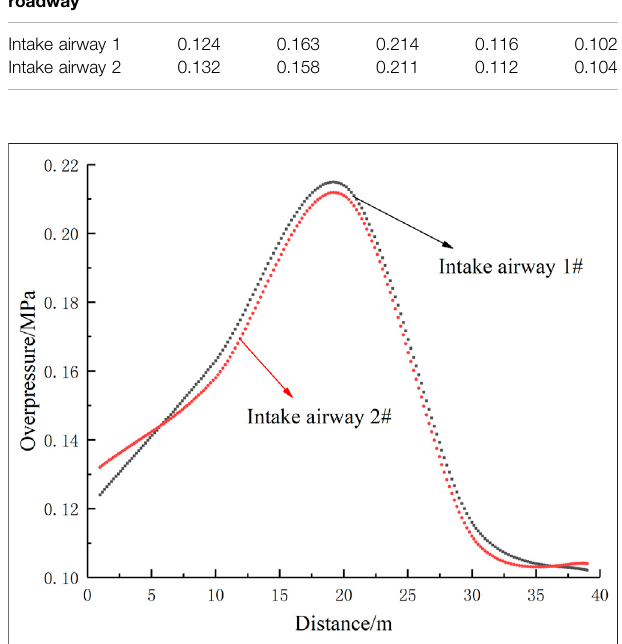
FIGURE 15 | Variation rule of attenuation rate of peak overpressure per 10-m intake airways 1 and